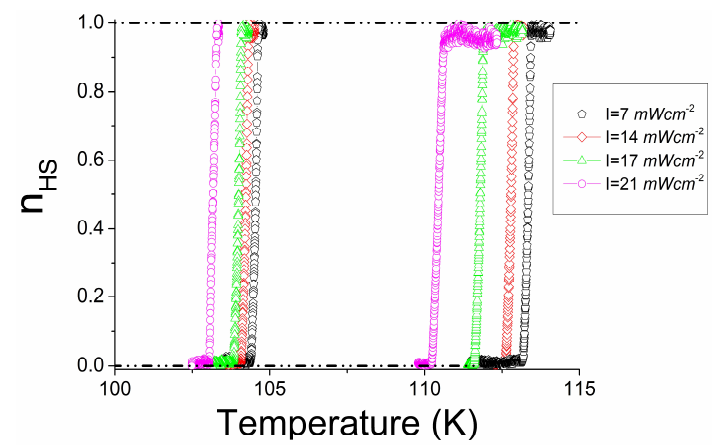
Figure 5. Set of thermal hystereses recorded at various shining intensities, with the temperature scan rate of 0.2 K min − 1 showing the shift of the thermal hysteresis to lower temperature regions as a result of photo-heating effects.